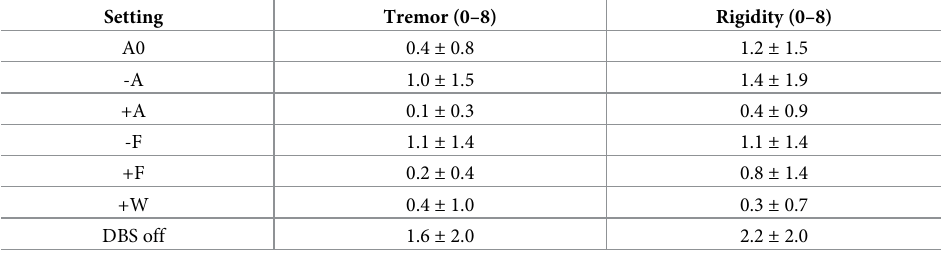
Table 2. Arm tremor and rigidity during settings (mean ± sd). The changes in arm tremor and rigidity were non-sig- nificant throughout the measurement. The arm tremor and rigidity increased due to a decrease in stimulation values (-A, -F, off) and decreased due to an increase in stimulation values (+A, +F) in certain patients. The changes were gen- erally small compared to the deviation.